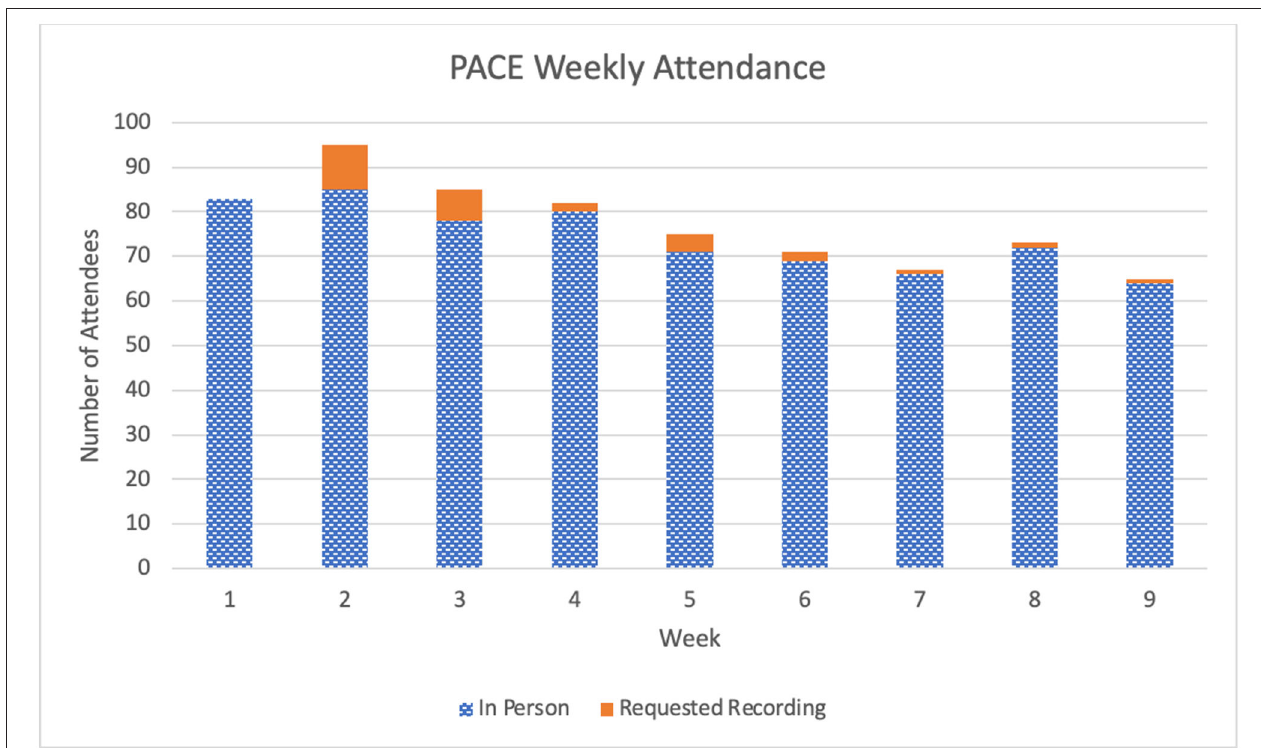
FIGURE 1 | Weekly participant attendance for